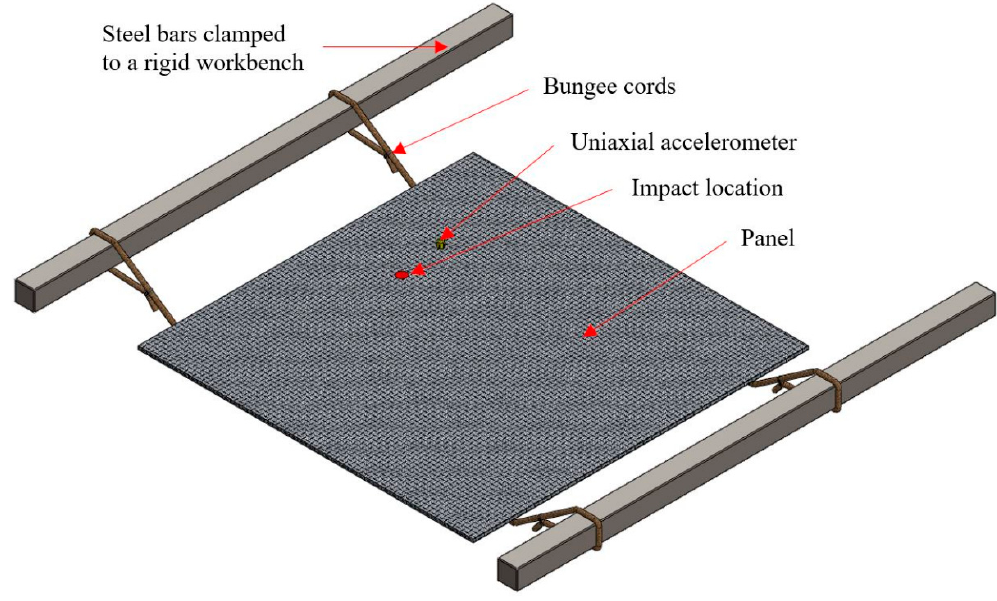
Figure 3. Suspension system for impulse excitation testing.